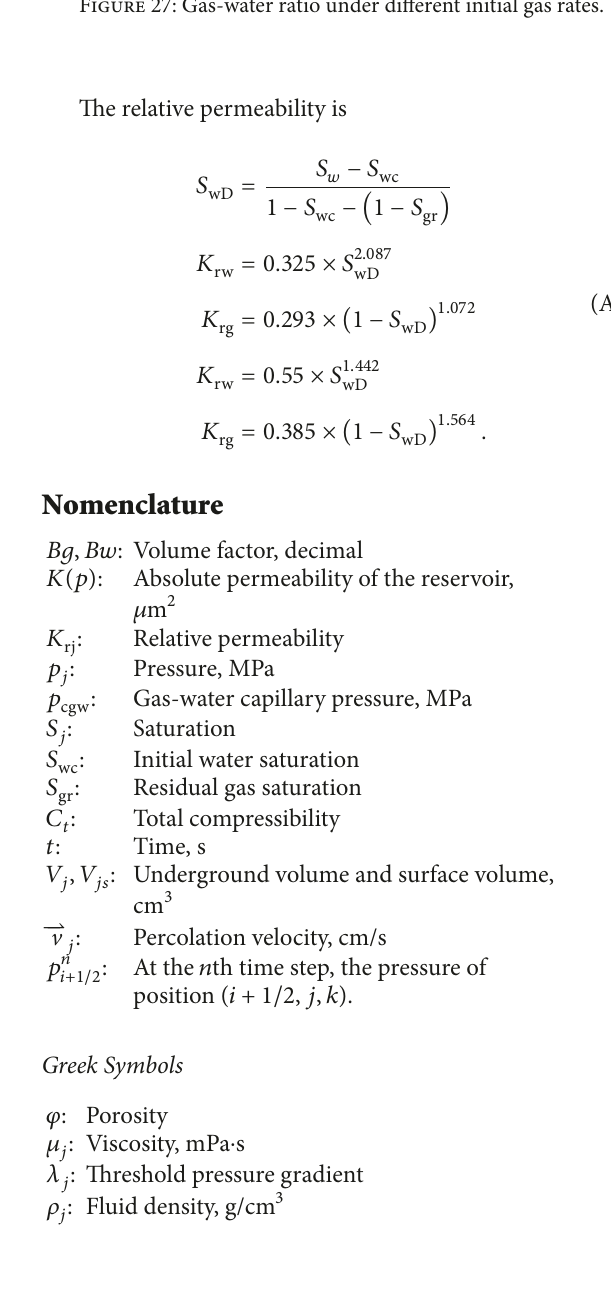
Figure 27: Gas-water ratio under different initial gas